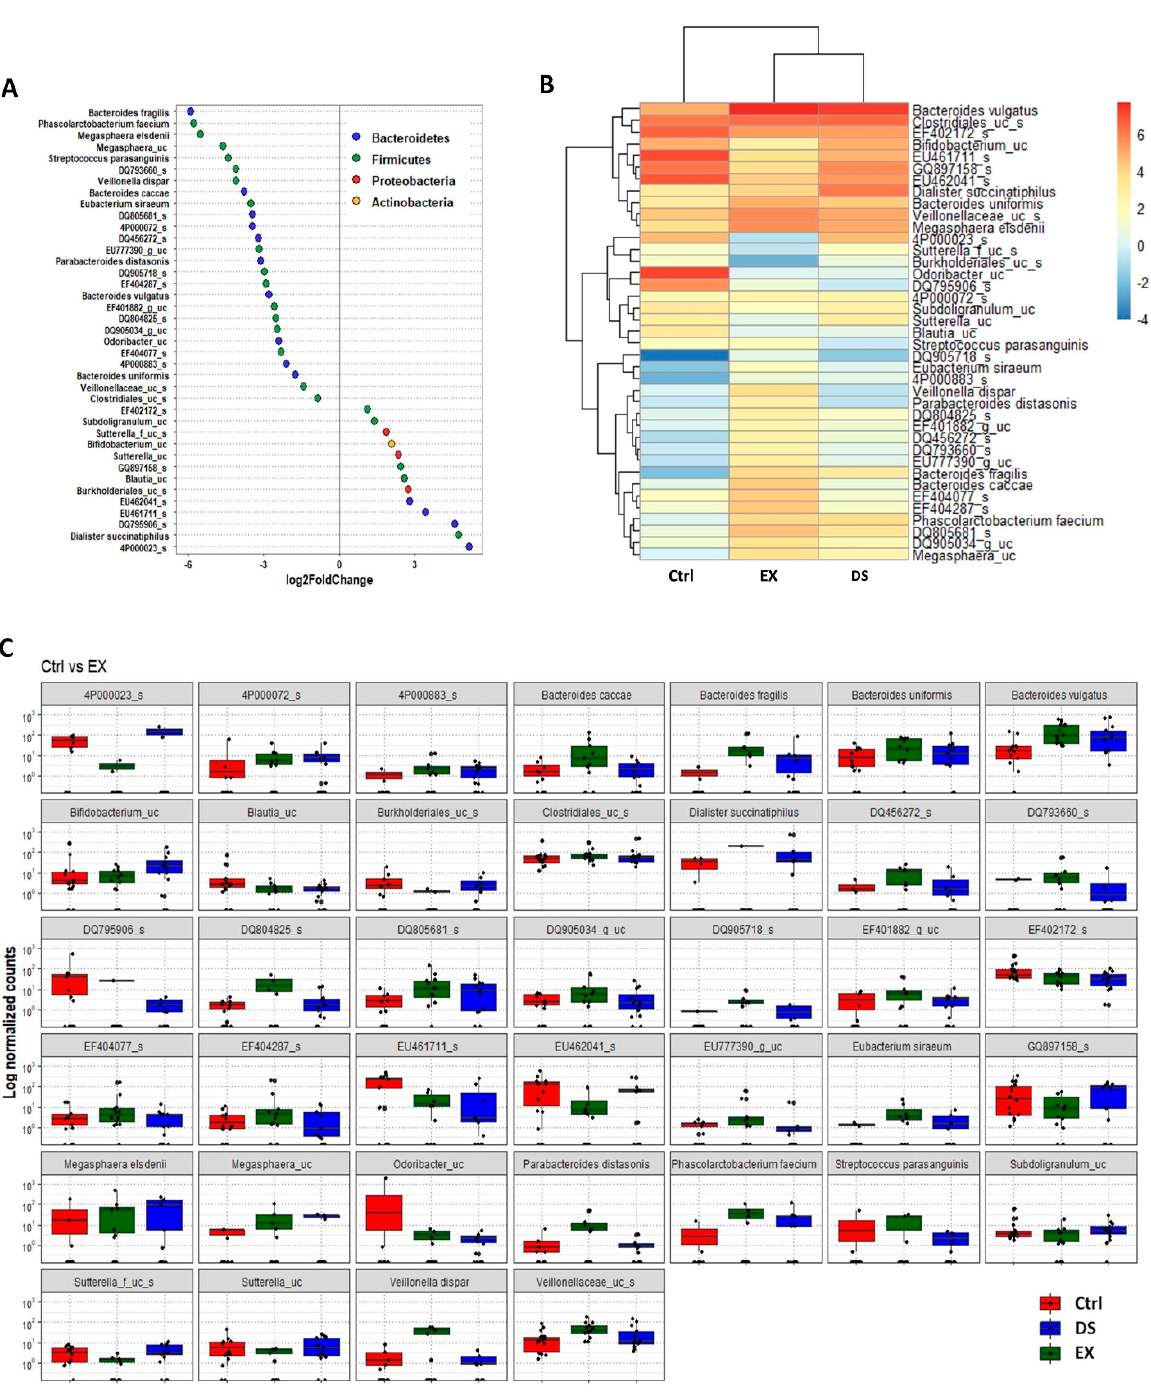
Figure 5. The key taxa changes between Ctrl and EX by differential abundance analysis. ( A ) Log2-fold change in abundance of most abundantly present species in the gut microbiome of the Ctrl and EX groups analyzed by DESeq2 differential abundance analysis. Each point represents a species comparison between two experimental groups. ( B ) Heatmap of most abundantly present species in the Ctrl and EX groups. ( C ) Normalized abundances of 39 significantly different bacterial species of interest that were identified from differential abundance analyses. Boxplots represent normalized count abundances of individual species in each group. p value < 0.05 was considered as significant. Ctrl and EX represent the control and exercise groups, respectively.